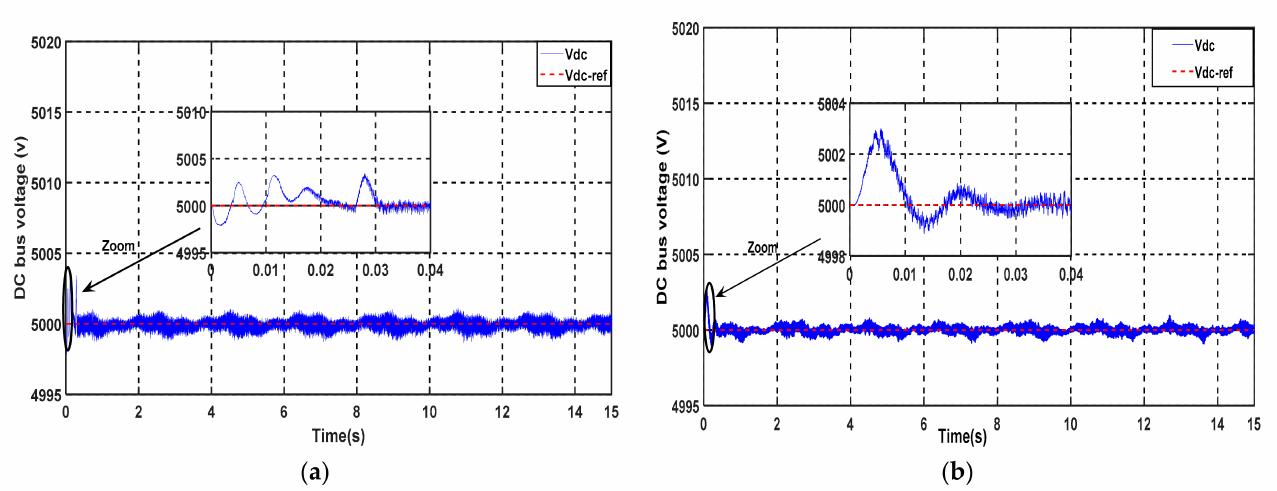
Figure 8. ( a ) Grid active power, ( b ) grid reactive power, and ( c ) power factor cos ϕ . Compared to the classic technique, Figure 9 shows that the DC bus voltage remains stable given the variation in the wind.